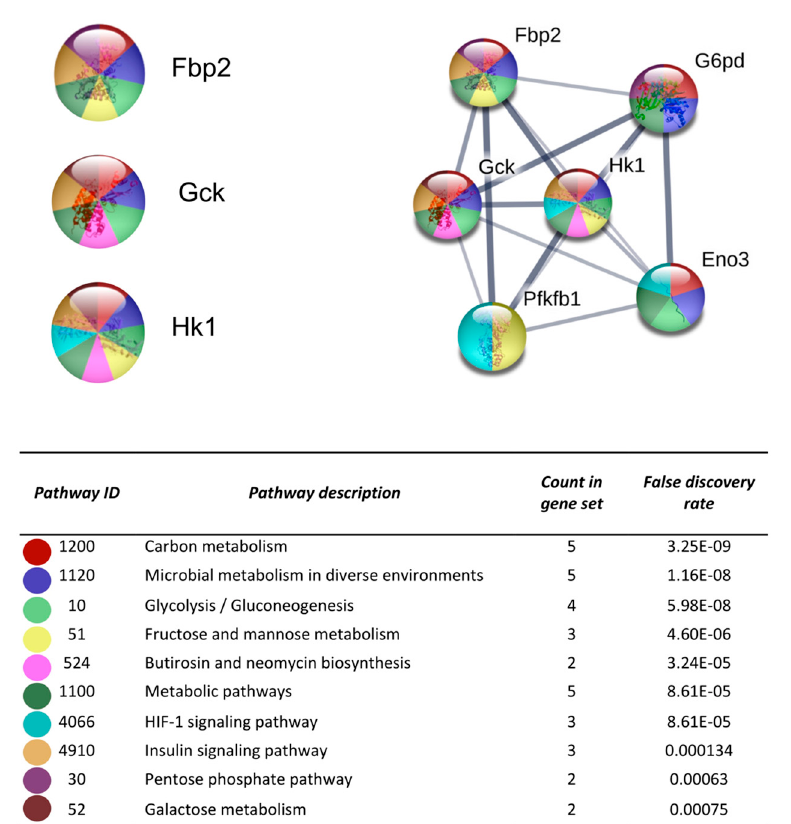
Figure 5. The protein-protein interaction network construction of the cluster number three obtained with the differentially expressed genes. The lists of the differentially expressed genes (Z-score ≥ 1.5 SD) were analyzed on the STRING and Cytoscape platforms. The primary clusters of sub-networks were obtained using the Molecular Complex Detection (MCODE) complement (cutoff = 0.2). Line thickness indicates the strength of data support; colored nodes indicate query proteins and first shell of interactors; white nodes indicate the second shell of interactors.